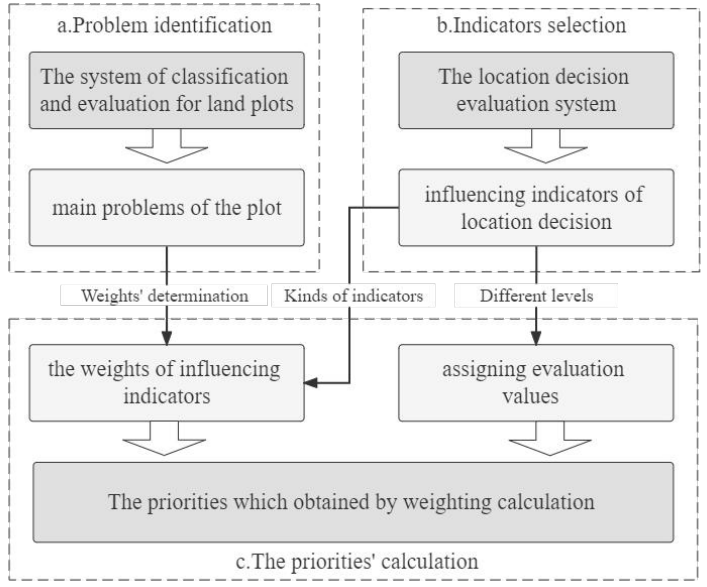
Figure 3. The relationship between the three parts of the method. ( a ) Identification of the main problem in the plot. ( b ) Selection of indicators influencing location decision. ( c ) Calculation of the priorities of the location decision.